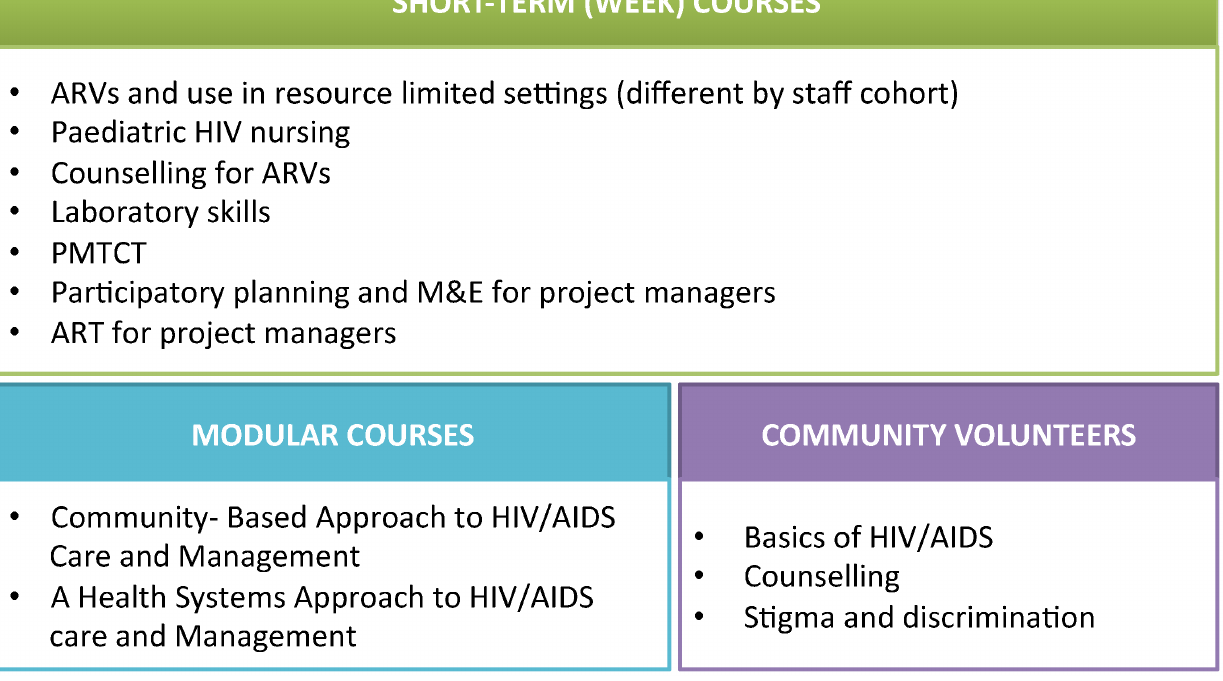
Figure 3. Capacity building for integrating family-centred care at partner facilities. Figure describes the courses designed by Mildmay and made available during partner facility service integration, as needs assessments determine. These include short-term (week) courses on skills sets like pediatric HIV nursing or laboratory skills, modular courses on more advanced subjects like community-based HIV care and health systems approaches, and training for community volunteers on HIV/AIDS basics and counseling skills.